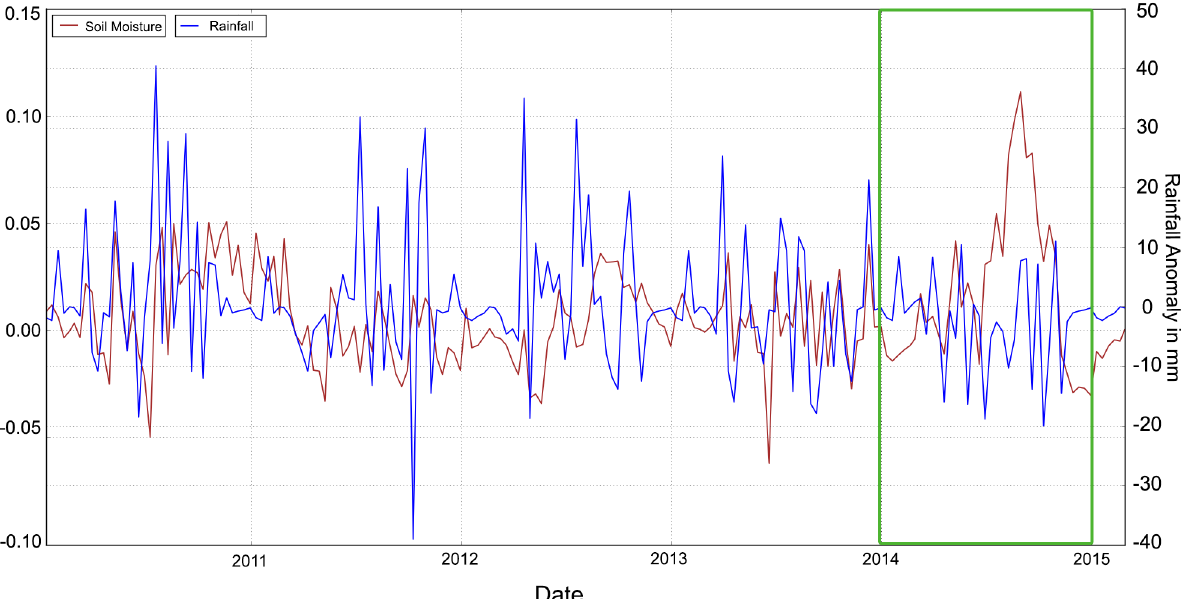
Fig 5. Satellite-derived time series of rainfall (blue) and soil moisture (brown) anomalies for the location of Kabo (18.61E/7.69N), covering January 2010 to May 2015 (the green rectangle highlights 2014).